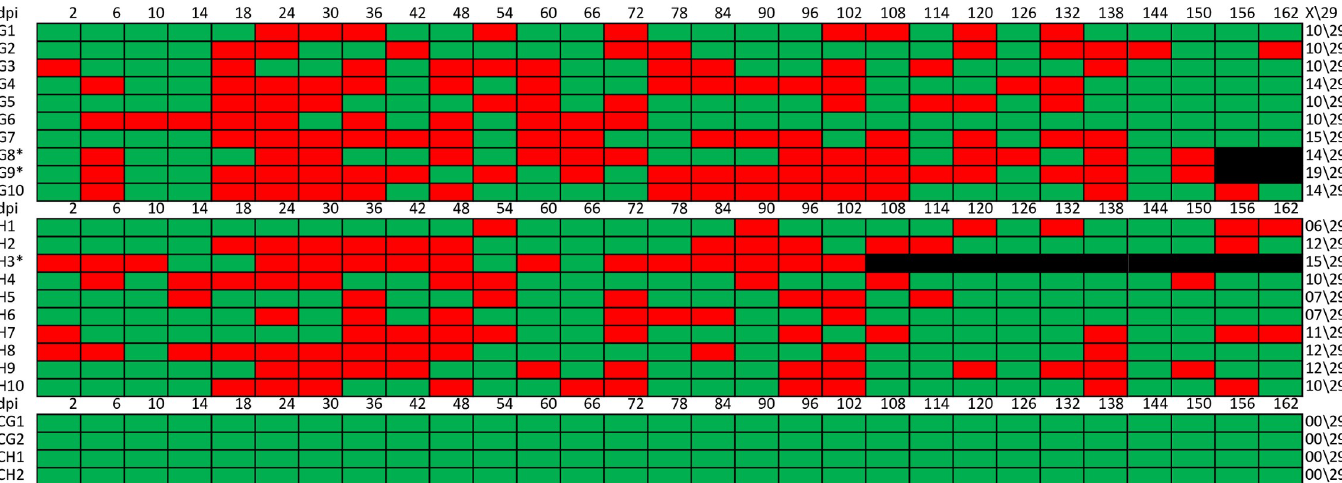
Fig 8. Number of positive RT PCR tests of swab samples during the trial; total test amount 29 G: T . graeca ; H: T . hermanni ; 1–10: Number of single animal; dpi: Days post inoculation Red: Positive; Green: Negative; Black: Not tested Last column presents positive results of total testing (29) in each animal, to show the high number of positive tests in early euthanized animals.